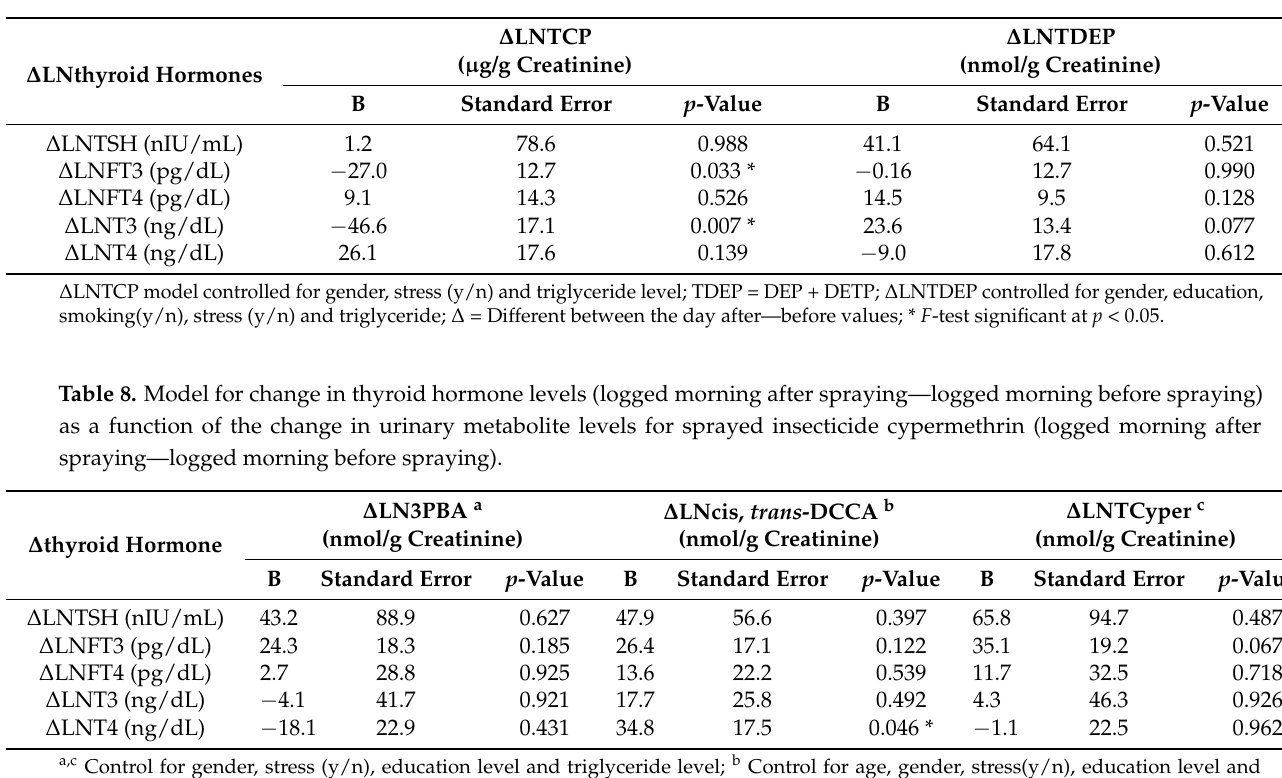
Table 7. Model for change in thyroid hormone levels (logged morning after spraying—logged morning before spraying) as a function of the change in urinary metabolite levels for sprayed insecticide chorpyrifos (logged morning after spraying— logged morning before spraying).